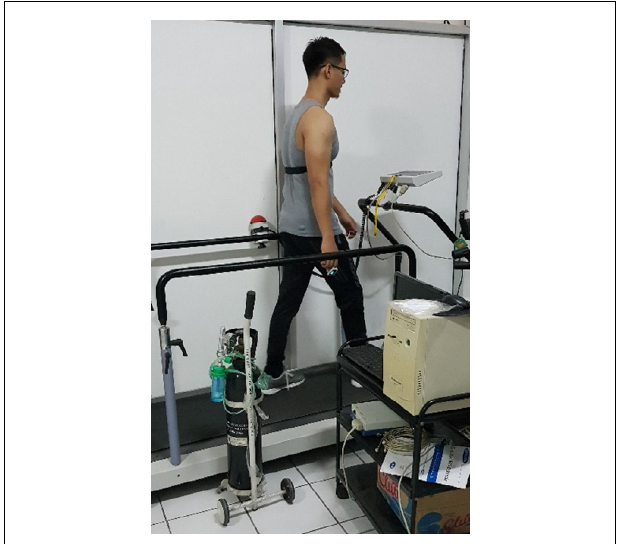
FIGURE 1 | Inclination group participants using Polar H10 (Figure permissions had been approved by subject).